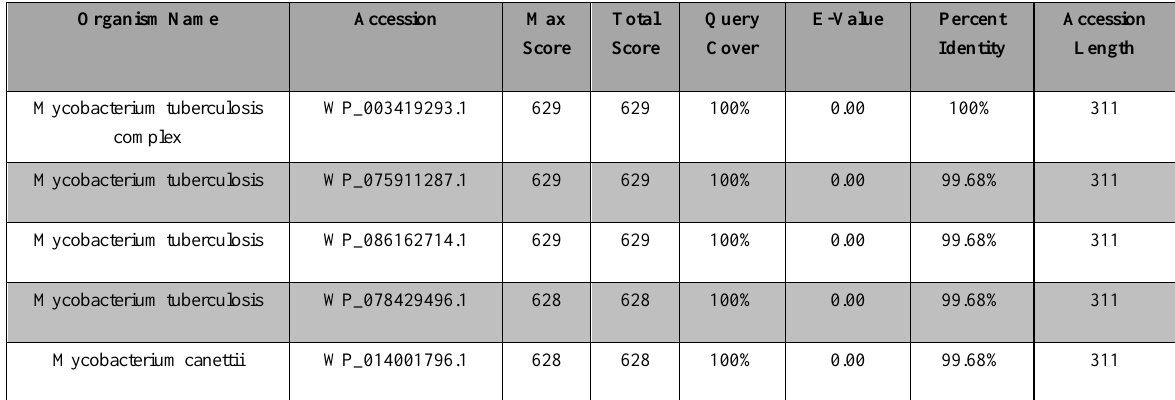
Table 2. The output of BLASTP against UniProt/Swissprot non-redundant sequences.